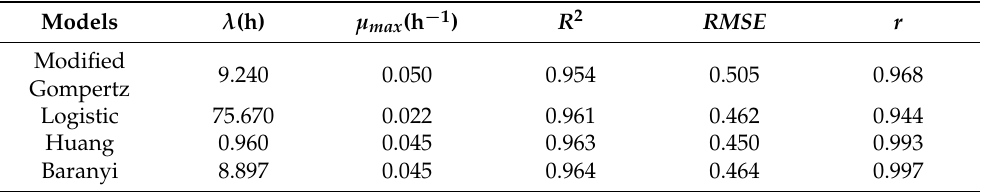
Table 9. Different kinetic-fitting models and parameters from scores of PC1–PC4 extracted by E-nose and E-tongue sensors for freshly squeezed strawberry juice during cold